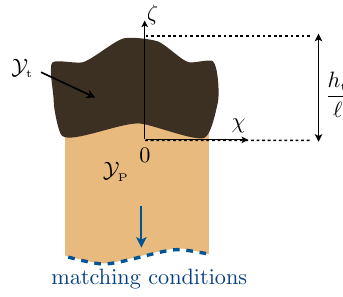
Figure A2. Elementary cell at the top of the plate in the χ = ( χ , ζ ) coordinate, in the unbounded two-dimensional region heterogeneity